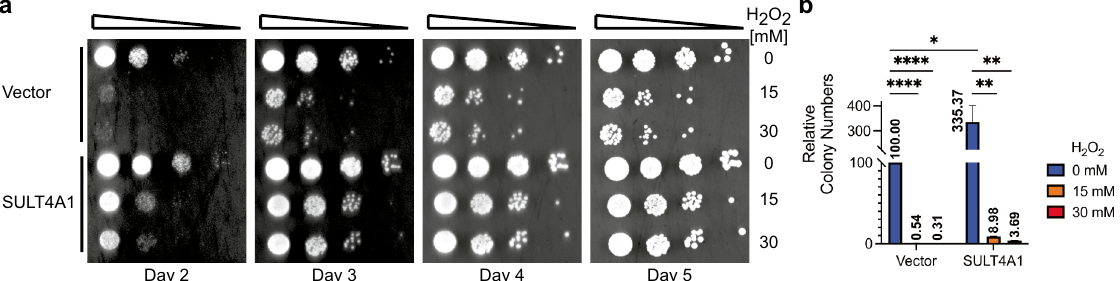
Figure 3. SULT4A1 protects yeast from H 2 O 2 induced cytotoxicity. Exponentially growing galactose-induced yeast transformed with YCpGAL1 SULT4A1 •L (SULT4A1) or control (vector) were aliquoted and treated with 0, 15 and 30 mM H 2 O 2 for 1 h at 30 °C, cultures were corrected to OD 595 of 0.3 and tenfold serial diluted. ( a ) Dilutions were spotted on galactose plates, incubated at 30 °C, and depicted is a representative picture from day 2 to 5. ( b ) Appropriate dilutions were spread on galactose plates and number of colonies were determined after 4 days at 30 °C. Depicted is the mean and SEM of relative colony number to vector control with no H 2 O 2 treatment of three independent experiments (relative colony number is shown in graph). Unpaired (two-tailed) t-test by Prism; *P < 0.05, **P < 0.01, ****P < brane, we treated purified mitochondria with trypsin to proteolyze outer mitochondrial proteins and peptides before isolating total mitochondria lysates. Trypsin treatment degraded all SULT4A1 but not the VADC/porin1 loading control and SULT4A1 was detected in the control sample—no trypsin (Fig. 2e). These results suggest that SULT4A1 is uniquely associated with the mitochondrial outer membrane at the cytosolic site and is not imbedded in the mitochondrial outer membrane as is VDAC/porin1 26 or associated with the mitochondrial inner membrane.